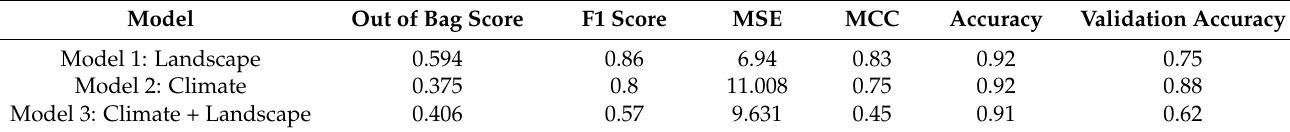
Table 3. Random Forest model scores for Out-of-Bag (OOB), F1, Mean Squared Error (MSE), Matthews Correlation Coefficient (MCC), Accuracy, and Validation Accuracy variables used in Multiple Logistic Regression analyses grouped by